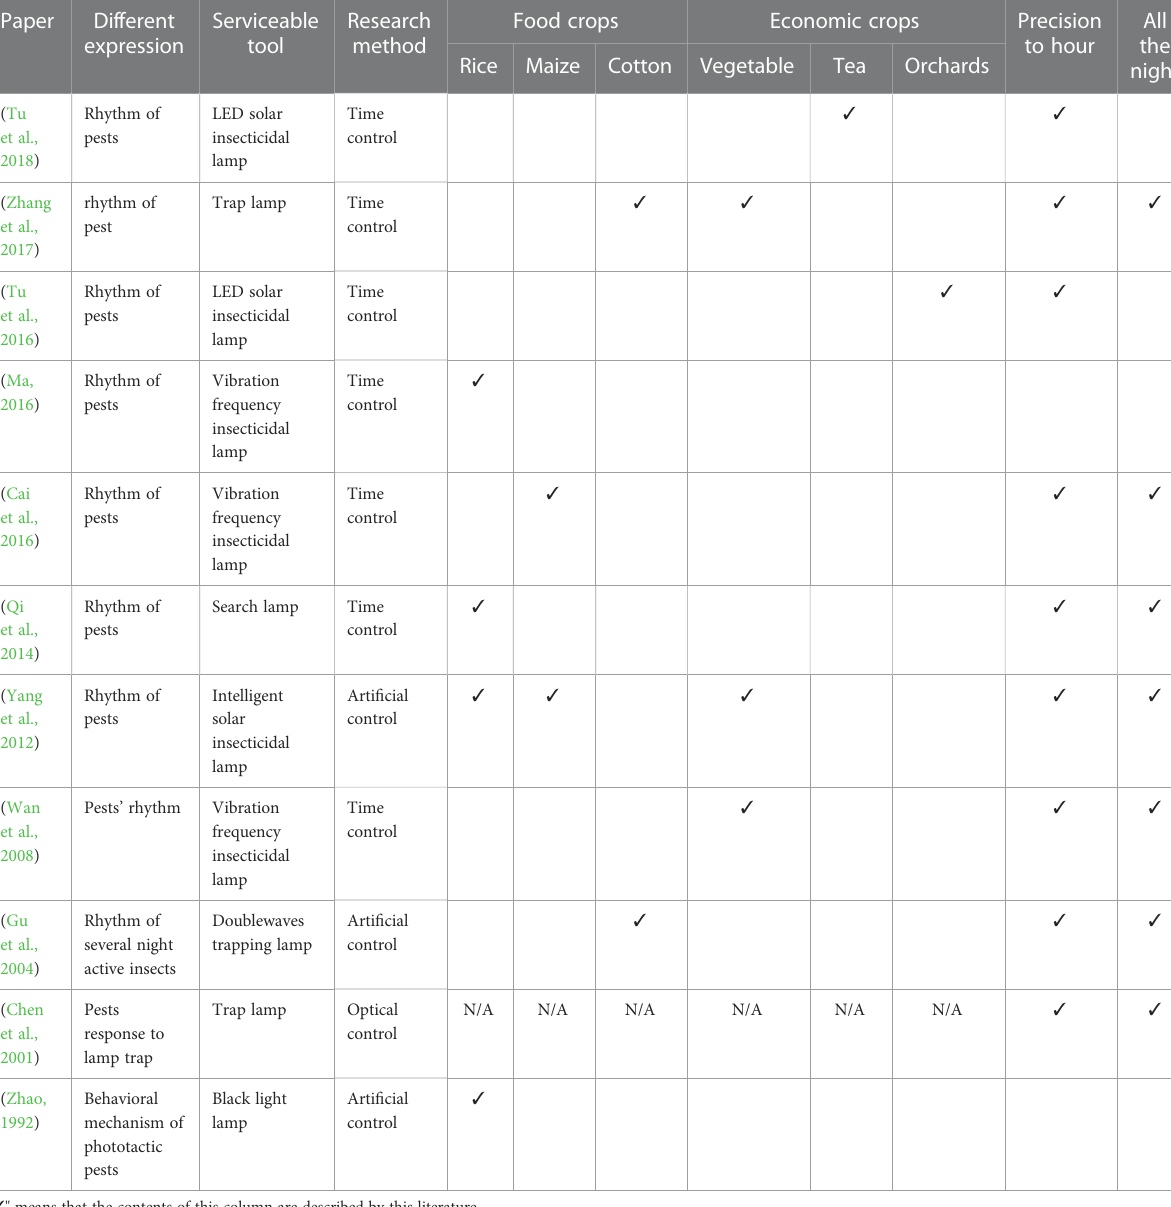
TABLE 3 Summary of research papers on the phototactic rhythm of pests in China.